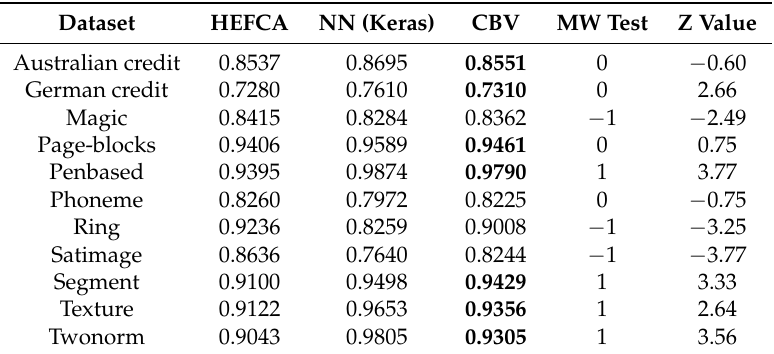
Table 2. Accuracy of HEFCA , neural network and CBV.